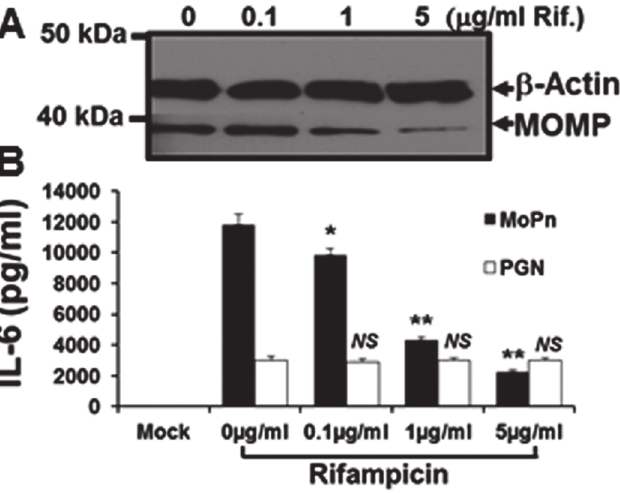
Fig 8. Rifampicin does not affect host-cell mechanisms. Bm1.11 cells were either mock-treated, treated with 10 μ g/ml of the purified E . coli peptidoglycan (PGN), or infected with 10 IFU/ cell C . muridarum , and cells were incubated in the presence of increasing concentrations of rifampicin starting at 2h post-treatment/ infection. After 24 h post-treatment/ infection, cell lysates and supernatants were harvested for: (A) western- blot analyses for the Chlamydia -specific major outer membrane protein (MOMP) and cellular β -actin. (B) ELISA analyses of PGN-induced versus Chlamydia -infection specific cytokine expression. The results shown are representative of three independent experiments . * = p < 0 . 05; ** = p < 0 . 01; NS = not statistically significant compared to control cells without rifampicin (0 μ g/ml); MoPn denotes Chlamydia infection